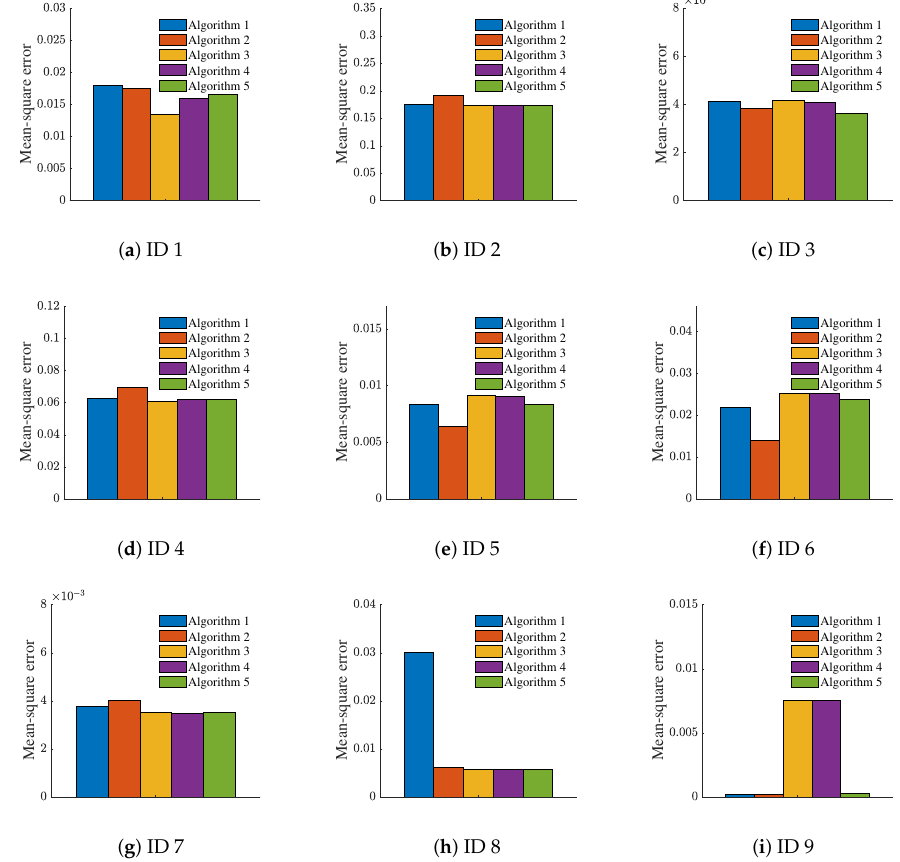
Figure 7. Average value of the mean-square error of five different attribute reductions. Each dataset is represented by ID